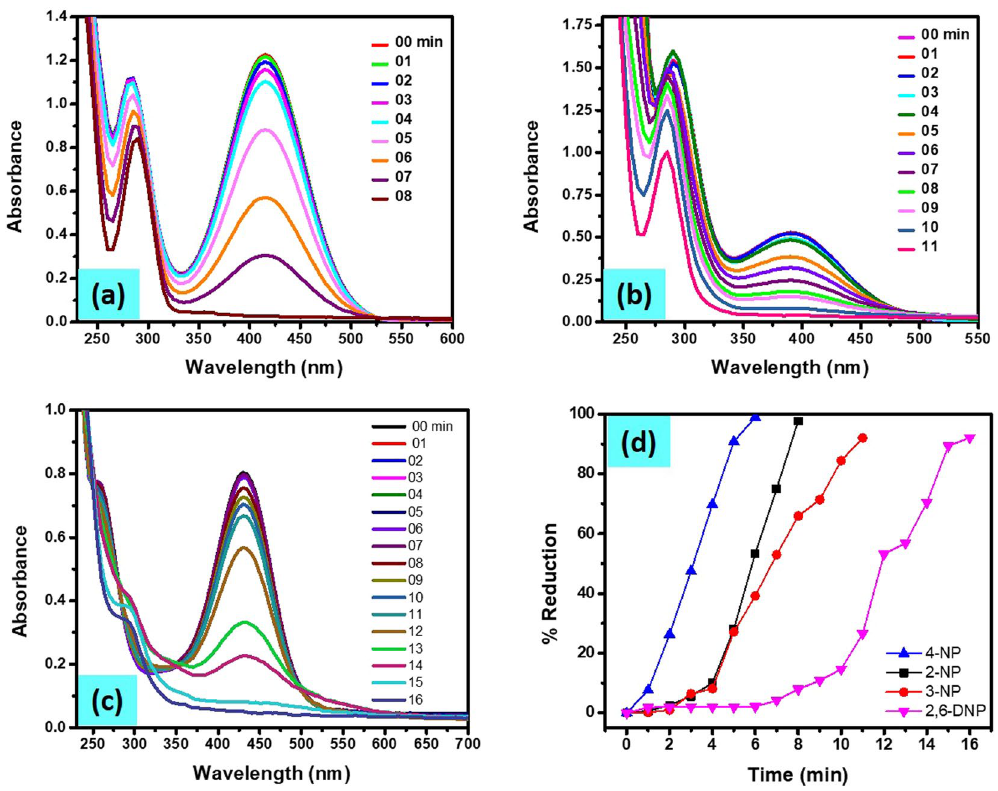
Figure 11. UV-vis spectra of 2-NP ( a ), 3-NP ( b ) and 2,6-DNP ( c ), percent reduction of nitrophenols as function of time ( d